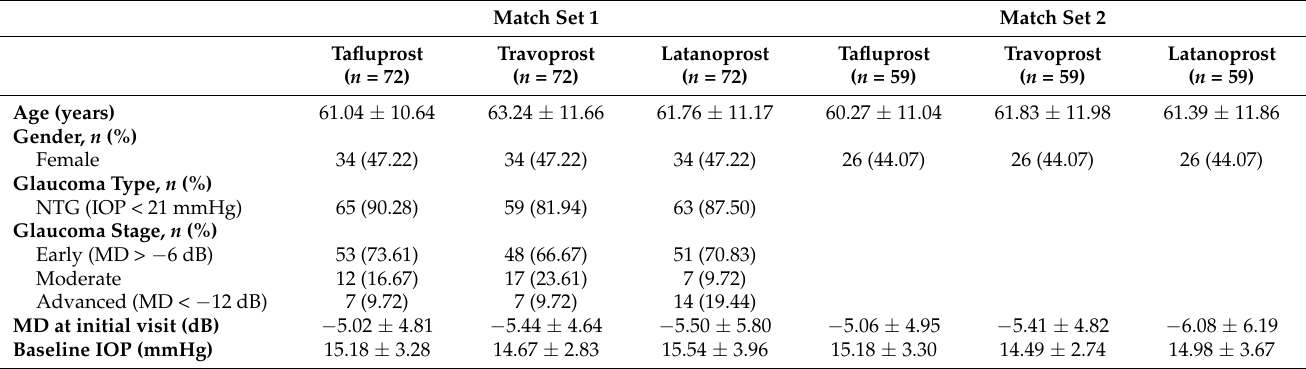
Table 1. Clinical characteristics of POAG or NTG patients (Match Set 1) and NTG patients only (Match Set 2). Match Set 1 Match Set